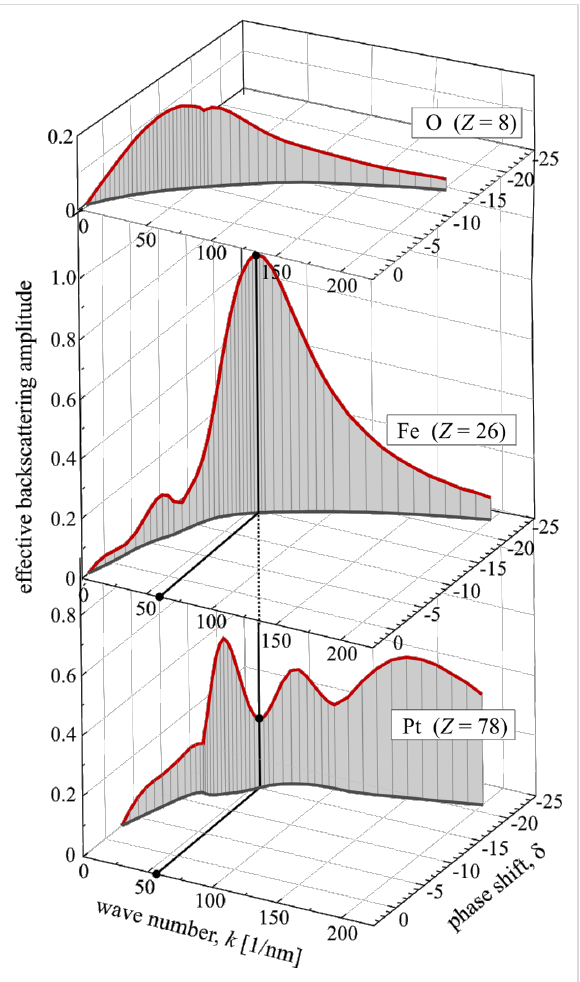
Figure 1: Effective backscattering amplitude of O, Fe, and Pt as a function of wave number and phase shift. At k = 60 nm − 1 Fe has it maximum backscattering amplitude, while it exhibits a local minimum in the case of Pt due to the Ramsauer–Townsend effect.